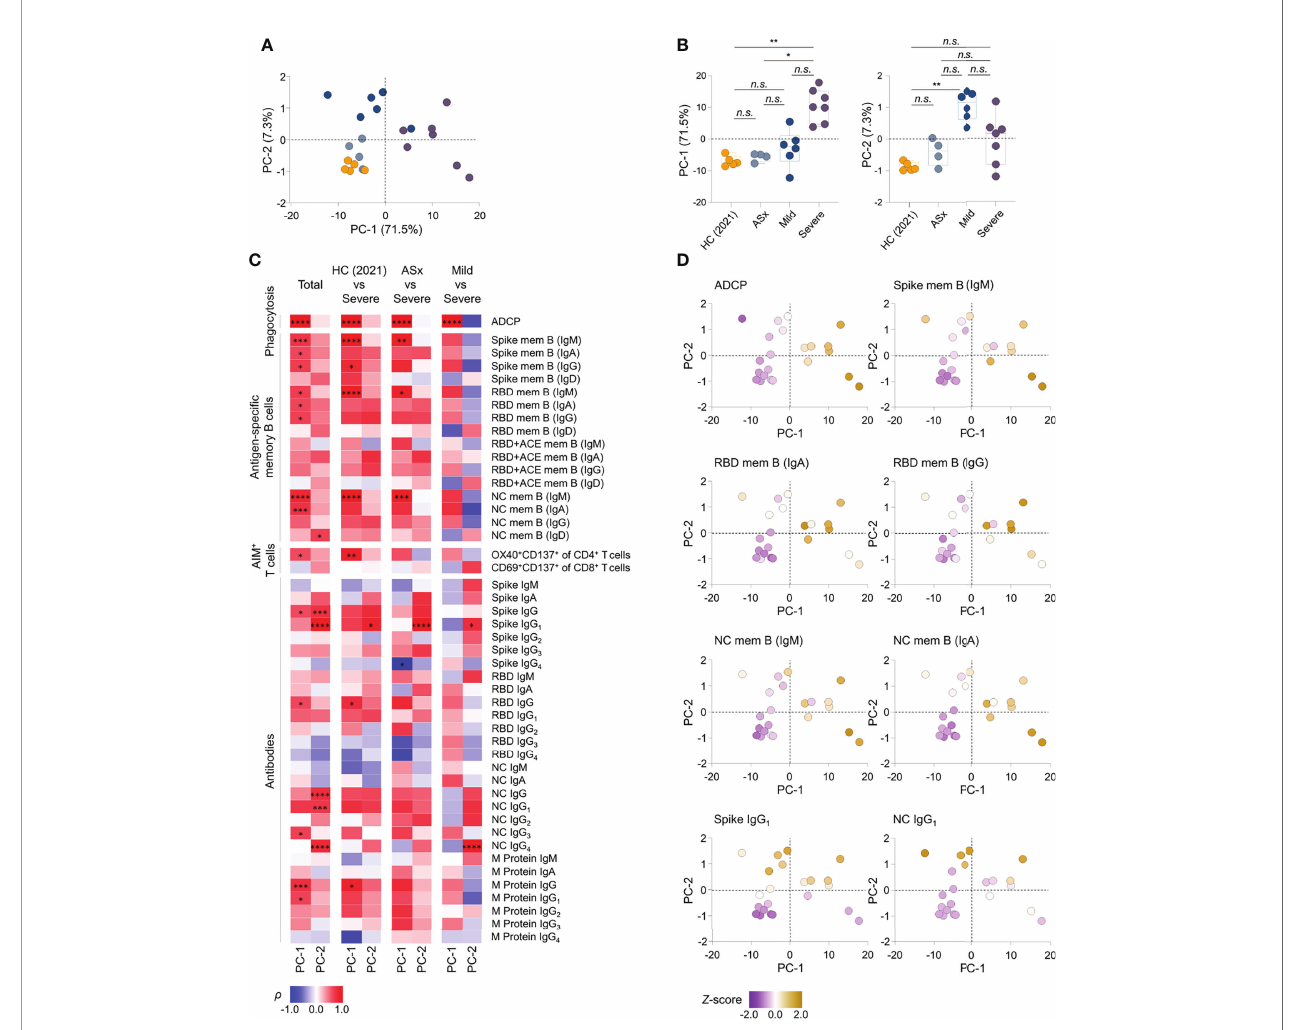
FIGURE 5 | Integrated analysis of immune components to SARS-CoV-2 according to the severity. (A) Principal component analysis (PCA) of aggregated immune responses data against SARS-CoV-2, namely, circulating Abs against SARS-CoV-2 proteins, the Ab-dependent phagocytic capability of plasma, and frequencies of antigen-speci fi c memory cells over disease severity of illness from PBMCs collected at 12 months in patients and healthy subject. HC (2021): healthy control ( n = 5), ASx: asymptomatic ( n = 4), Mild ( n = 6), Severe ( n = 7). (B) Summary boxplots of PC-1 and PC-2 scores over disease severity of illness. Statistics were calculated using non- parametric ANOVA with correction for multiple comparisons using statistical hypothesis testing (Dunn ’ s test) ( n.s .: P > 0.05, * P < 0.05, ** P < 0.01, *** P < 0.001). Boxplots represent median with interquartile range. (C) Correlations of antigen-speci fi c immune responses against the PC-1 and PC-2, displaying contributions of 47 immune components to PC-1 and PC-2 in group comparisons. The color represents Spearman ’ s rank correlation coef fi cient ( r ); red color indicates positive correlations, and blue indicates negative correlations among patient groups of disease severity. Statistics were adjusted using Bonferroni correction in the consideration of multiple statistical hypothesis n.s.: adj. P >0.05, * adj. P < 0.05, ** adj. P < 0.01, *** adj. P < 0.005, **** adj. P < 0.001. (D) Representative scatter plots displaying the relative levels of selected features onto PC space. The color represents z -score of each feature according to heat scale ranges from purple (low) to yellowish brown (high) color. PC-1, principal component-1; PC-2, principal component-2; mem B, memory B